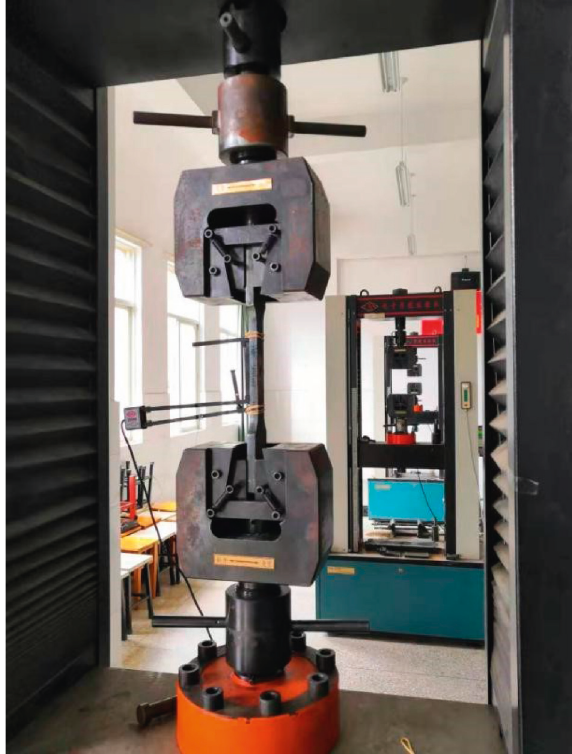
Figure 9: Steel tensile test. Table 1: Steel tensile test data sheet.